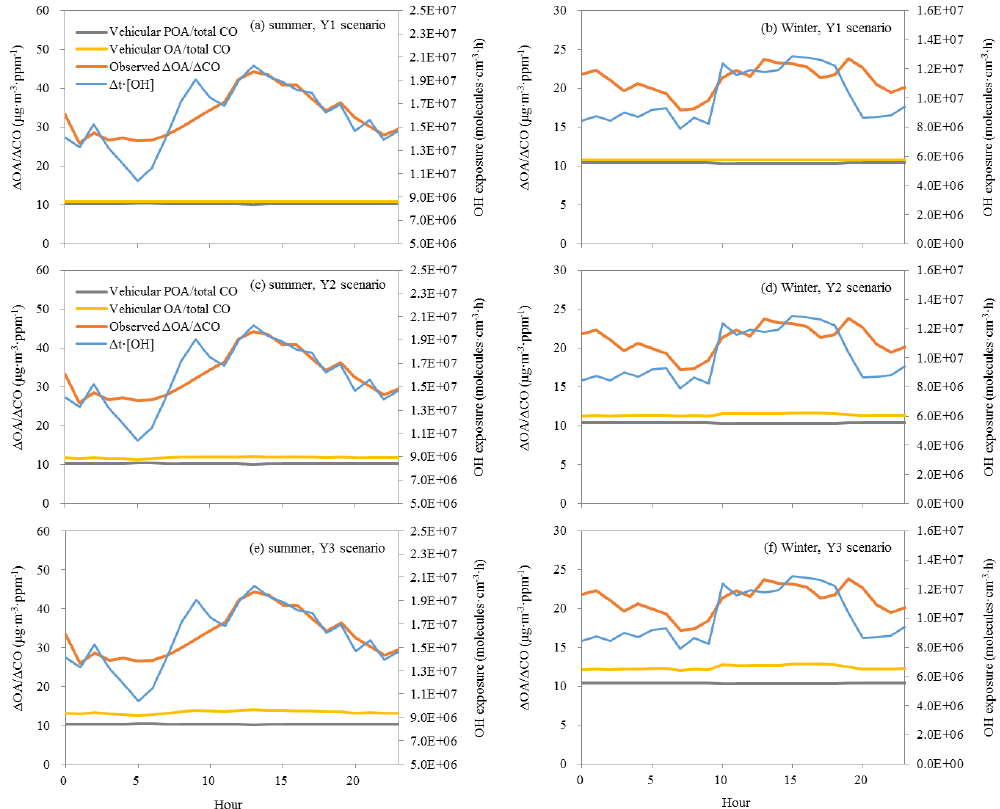
Figure 7. Diurnal variations of observed (cid:49) OA /(cid:49) CO in the atmosphere (red line), OH exposures (blue line), and the ratios of vehicular POA emissions (gray line) and OA formation (orange line) to total CO emissions with the SOA yields in three scenarios (Y1, Y2, and Y3) in summer and winter in the urban area of Shanghai for the year of